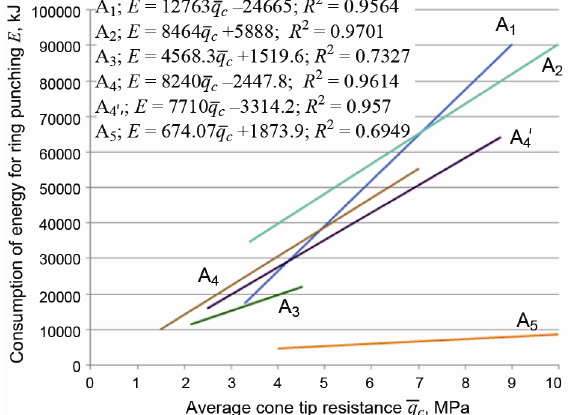
Fig. 8. Influence of soil conditions on the consumption of ener- gy for ring punching, using the linear dependence regression equation